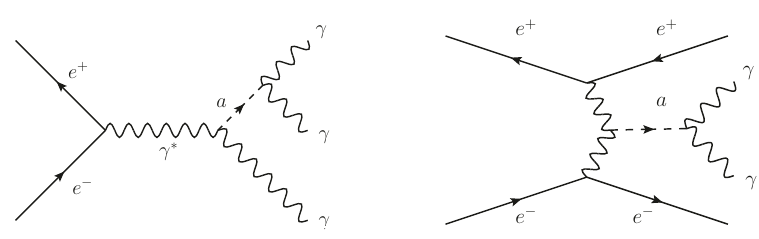
Figure 1 . Feynman diagrams for ALP production in e + e (cid:0) collisions via ALP-strahlung (left) and photon fusion (right) and the subsequent decay of the ALP into two